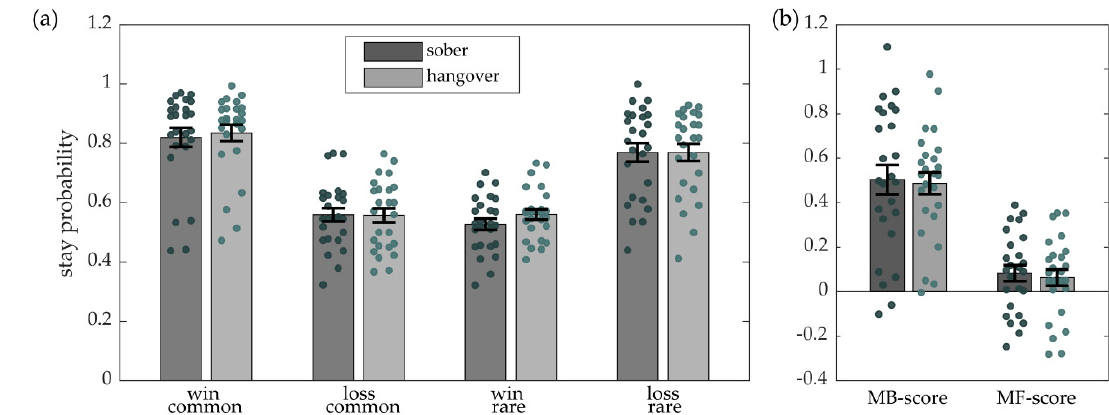
Figure 2. First stage choice behavior. Dots indicate values of individual participants and bars indicate group means with error bars depicting the standard error of the mean. ( a ) Stay probability (choosing the same options as in the previous trial) for win and loss trials as a function of transition (common vs. rare). The sober session is depicted in dark grey and the hangover session is depicted in light grey. ( b ) Model-based score (MB-score), reflecting the interaction between outcome and transition type, and model-free score (MF-score), reflecting the main e ff ect of outcome, for the sober session (dark grey) and the hangover session (light